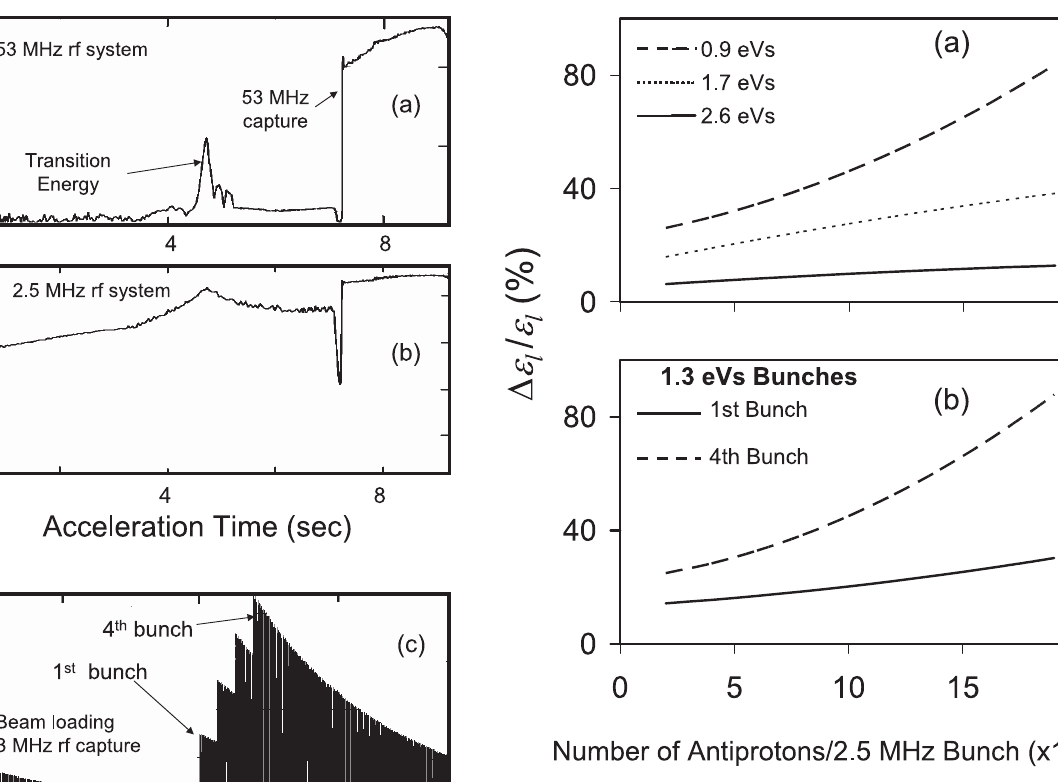
FIG. 5. The predicted " (95%) growth as a function of anti- l proton bunch intensity from ESME simulations for beam accel- eration from 9–150 GeV. Calculations are carried out including (cid:2) 95% (cid:3) (cid:1) 0 : 9 , 1.7, growth for " BLC as in Table I. (a) Average " l l growth for the first bunch and the and 2.6 eV s bunches. (b) " l (cid:2) initial (cid:3) (cid:1) 1 : 3 eV s last bunch in the case of " l in l